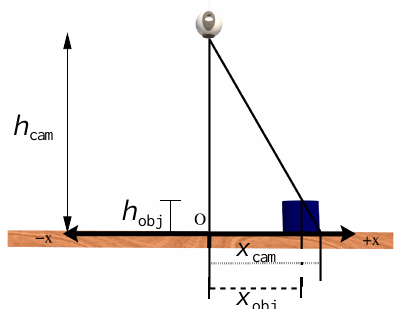
Figure 15. Correction of the object position due to its height.